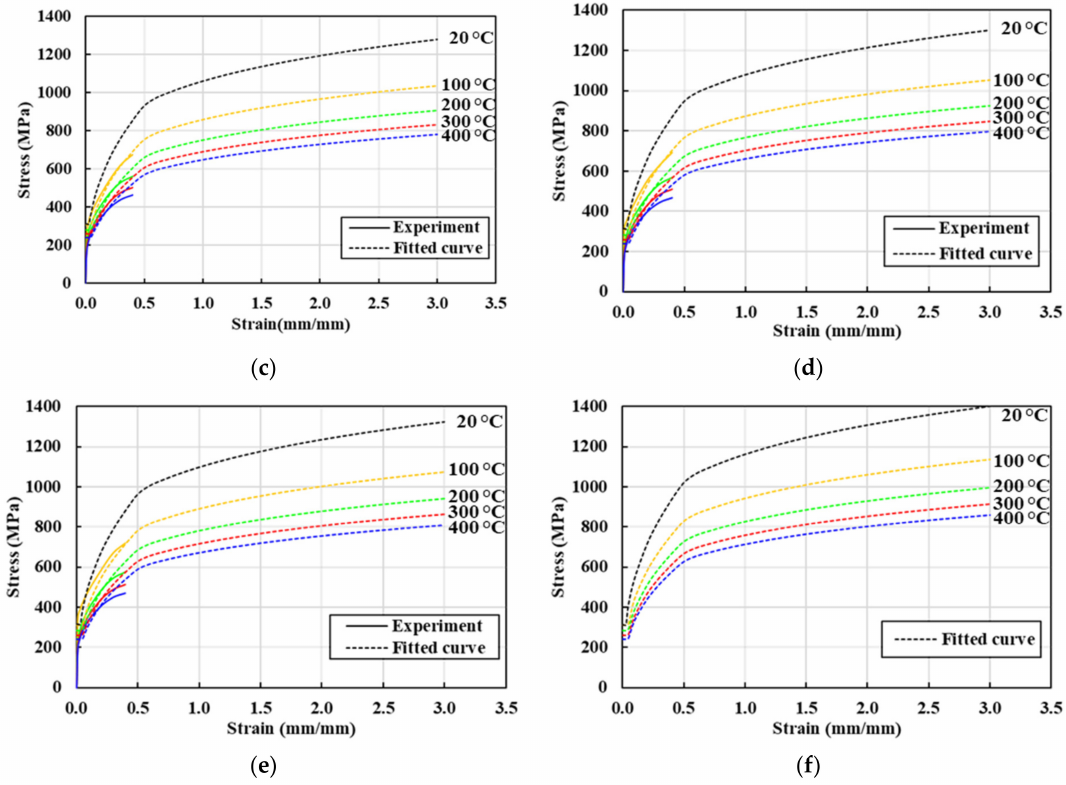
Figure 7. Flow stress curves (dotted lines) covering the entire ranges of the state variables: ( a ) 0 / s; ( b ) 1 / s; ( c ) 5 / s; ( d ) 10 / s; ( e ) 20 / s; ( f ) 200 / s. Table 2. Fitted flow stress errors by experimental flow